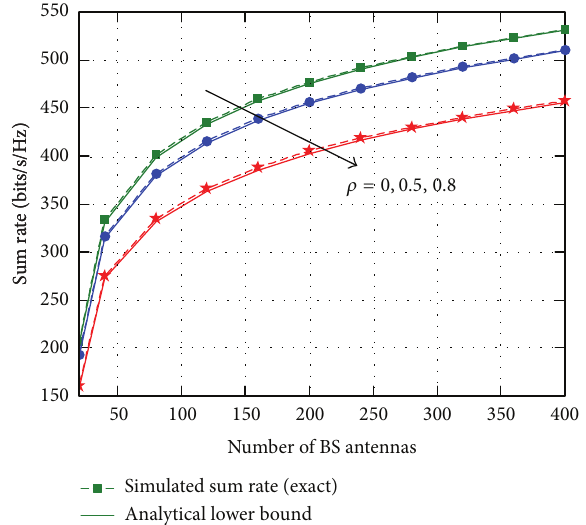
Figure 5: Analytical sum rate and lower bound versus the number of BS antennas ( 𝛾 = 10 dB, 𝑁 𝑡 = 2 , 𝐾 = 9 , 𝜌 = 0,0.5, 0.8 ).